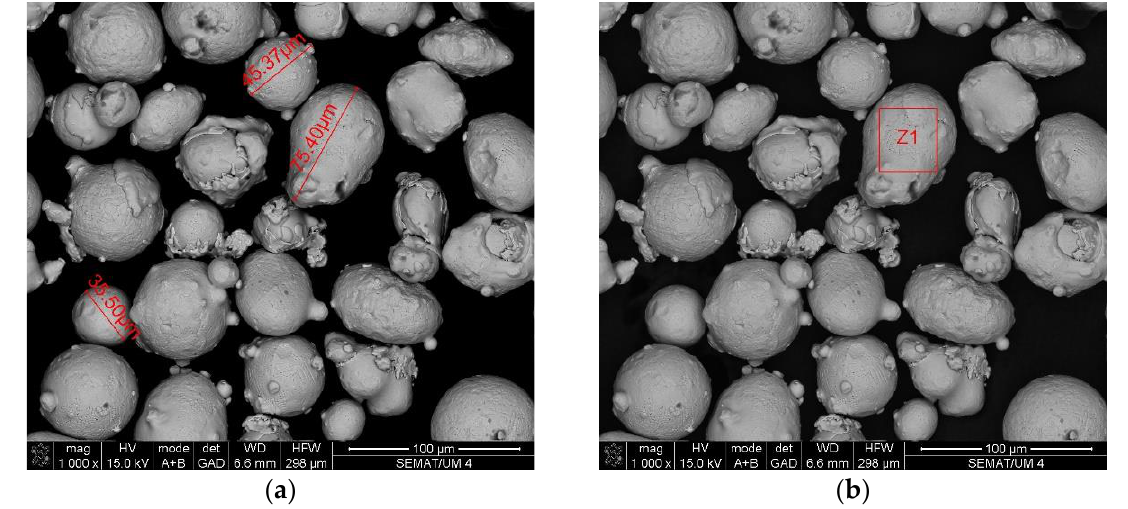
Figure 5. SEM analysis results: Stainless steel 316L powder after AM process. ( a ) Size and shape of particles in the sample; ( b ) image of the particle analyzed by EDS (results in Figure